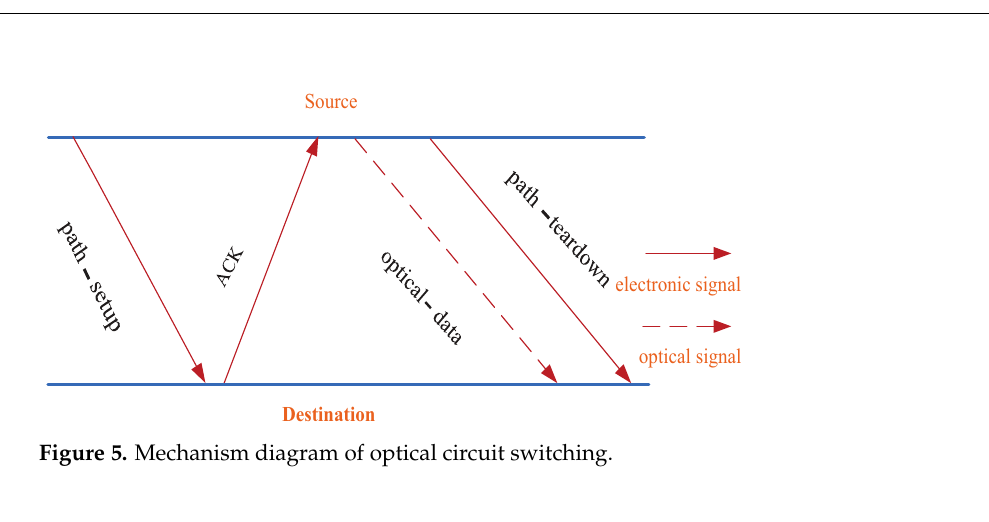
Algorithm 1: Routing algorithm based on the Dijkstra